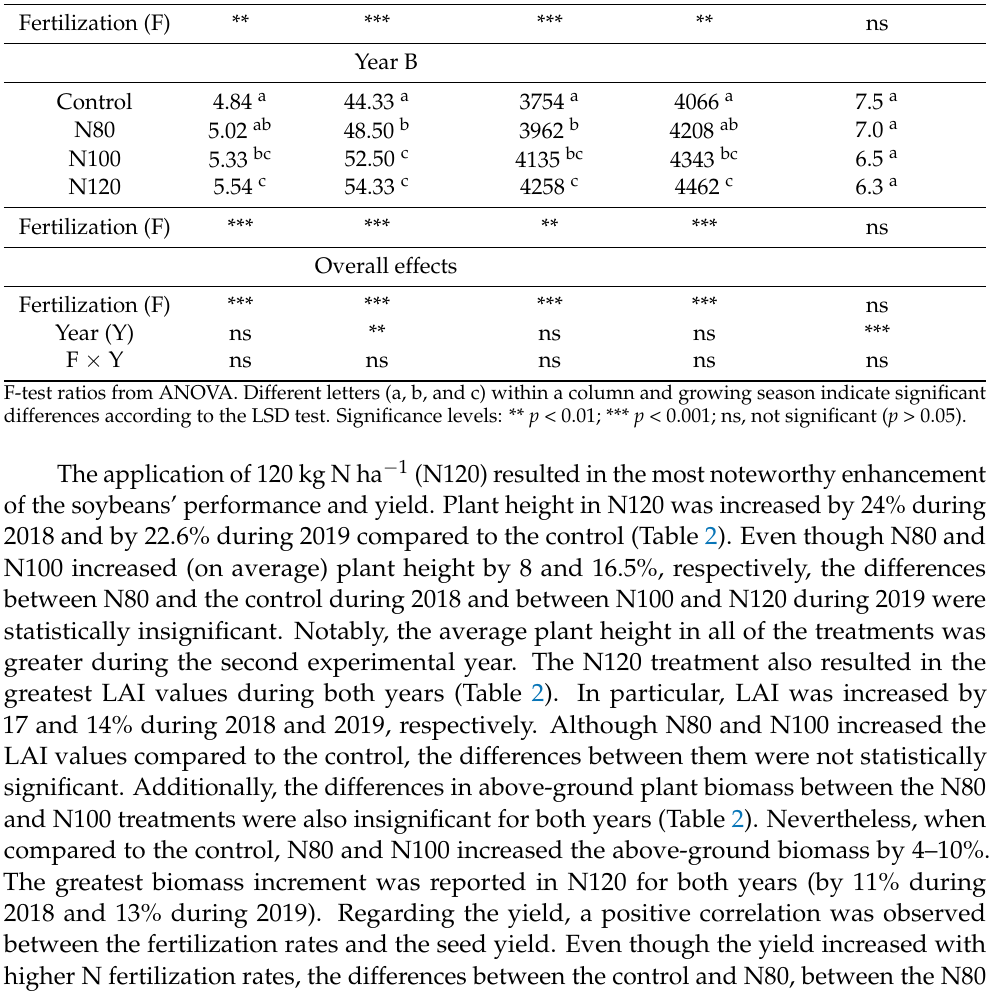
Plant Biomass Yield (kg ha − 1 ) (kg ha − 1